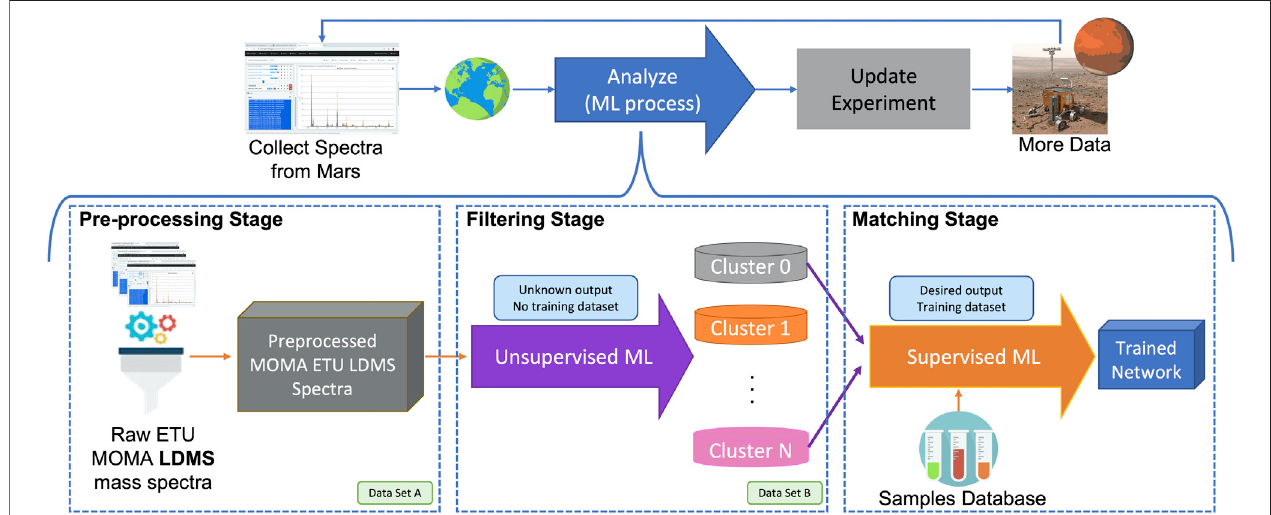
FIGURE 3 | Illustration of the 3-stage machine learning pipeline LDMS ETU data. These three steps are divided into: 1 ) a pre-processing stage where LDMS raw input data are transformed into a ML-readable format; 2 ) a fi ltering stage using unsupervised ML algorithms aiming at clustering the data into different clusters based on their patterns similarities; 3 ) a matching stage using supervised ML algorithms aiming at predicting the type of the samples studied (predictions are composed of “ category ” label and “ sample ” label, discussed